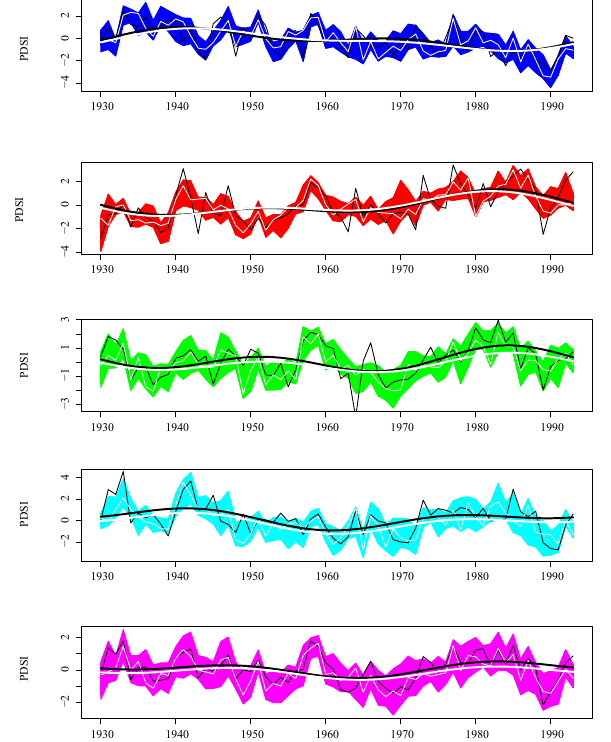
Figure 3. Comparison between observed (white) and reconstructed (black) summer PDSI series for each region of SSA during the calibration period (1930-1993). Bold lines are loess smoothings. The 95% confidence intervals correspond to the colored zones. This color code will prevail in the next figures.